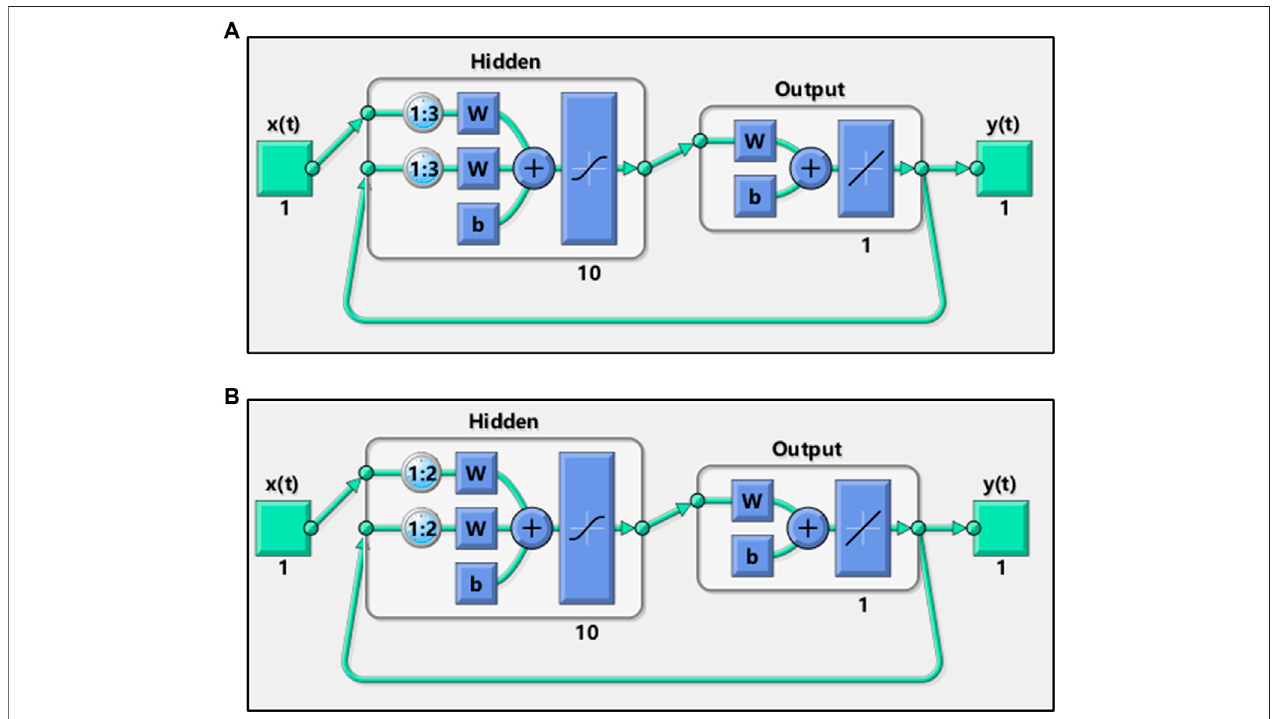
FIGURE 9 | Structures of the neural network for the (A) fi rst series and (B) second series.